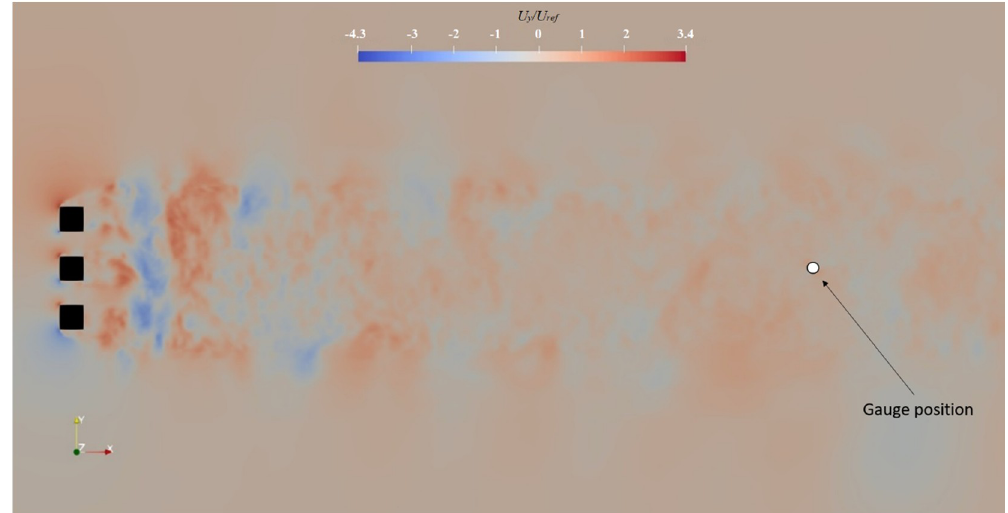
Figure 9. Normalized transversal component (U y / U ref ) of the instantaneous flow velocity in the horizontal plane ( x , y ) at the gauge collector elevation for the turbulent free-stream conditions.